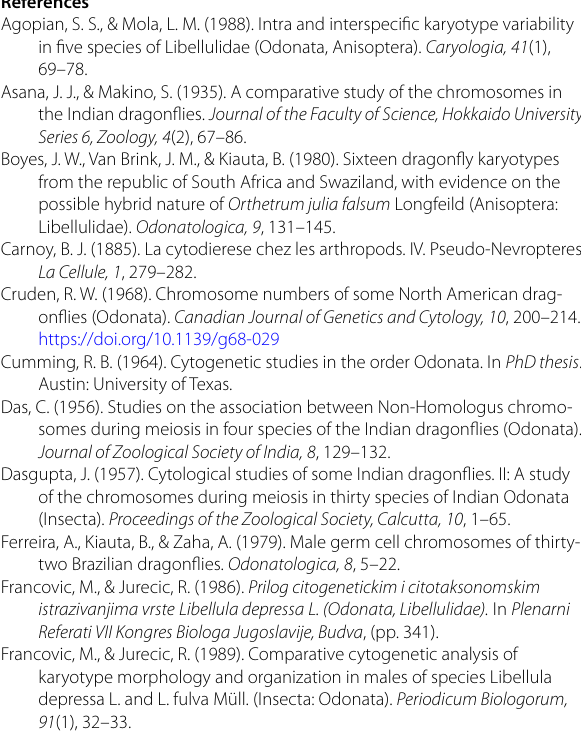
Referati VII Kongres Biologa Jugoslavije, Budva , (pp. 341). Francovic, M., & Jurecic, R. (1989). Comparative cytogenetic analysis of